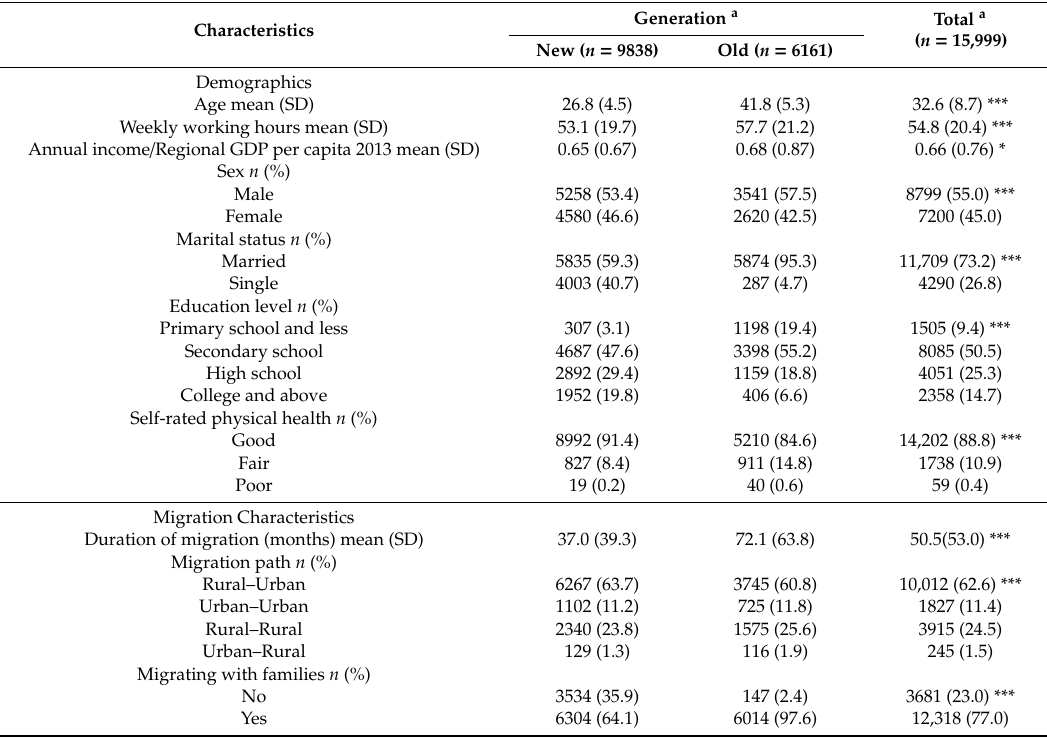
Table 1. Characteristics of 15,999 internal migrants (IMs) in China,